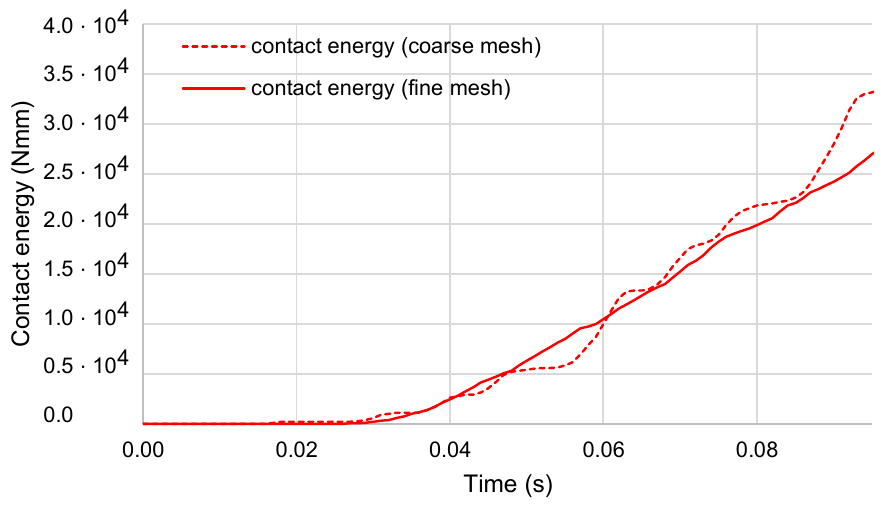
Figure 7. Comparison of contact energies between the coarse and fine meshing of the rod using the segment-based contact penalty formulation to form the adaptive joining element.